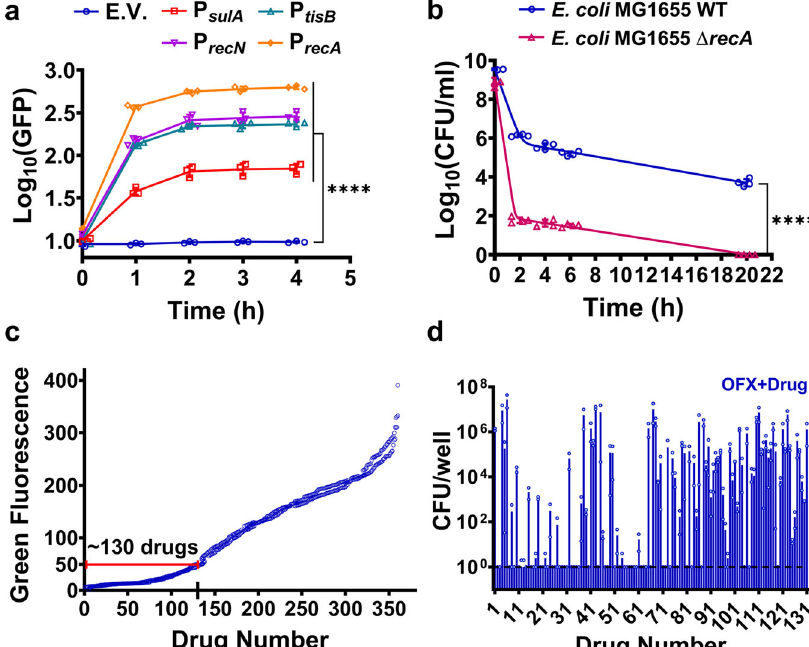
Fig. 1 Screening assay to identify chemicals that eliminate bacterial persisters. a Induction of the SOS response by OFX. Cells ( E. coli MG1655) with reporter plasmids expressing SOS genes were grown in Luria-Bertani (LB) medium, treated with OFX (5 µ g/ml) at early stationary phase ( t = 5 h) and assessed for GFP expression with a plate reader. Control: Empty vector (E.V.). Number of independent biological replicates, n = 3. b Persister levels in a recA mutant. WT or Δ recA E. coli MG1655 strains at early stationary phase in LB were treated with OFX for 20 h. Colony forming units (CFU) were determined by plating on LB agar medium. A non-linear model was used to generate the biphasic kill curves. F-statistics were used to perform statistical signi fi cance tests. n = 4. c Drug screening. Early stationary phase cells ( E. coli MG1655 strain with pUA66 P recA - gfp ) in LB were treated with OFX